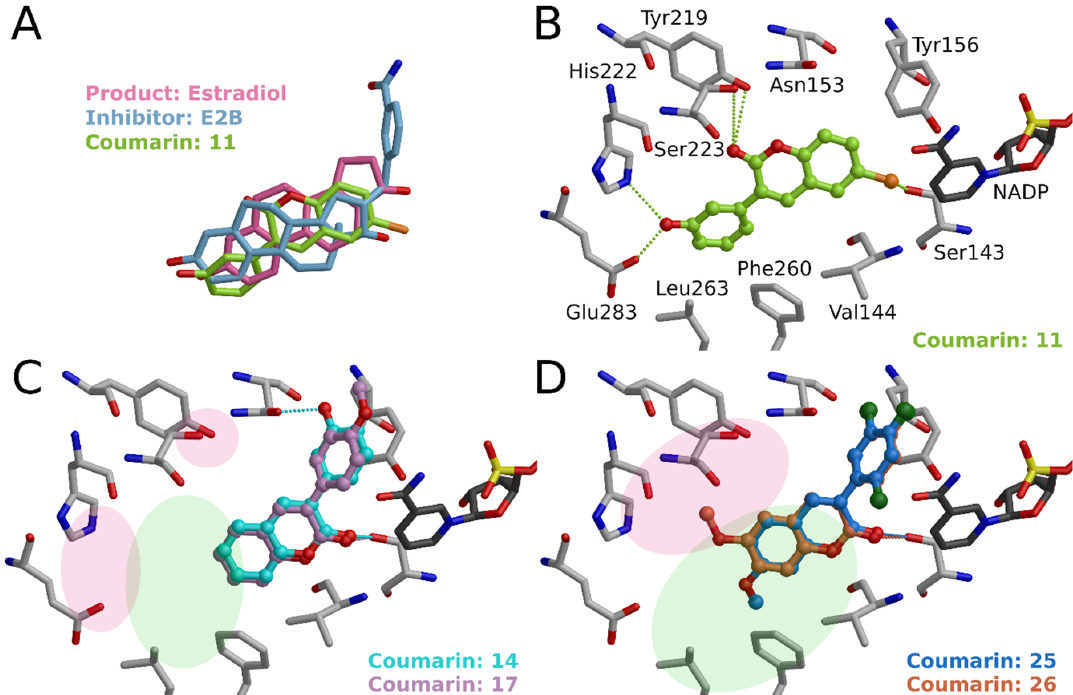
Figure 7. Binding of 3-phenylcoumarins to HSD1. ( A ) Comparison of possible binding conformations of estradiol (PDB: 1A27 [16]), E2B inhibitor (PDB: 3HB5 [17]), and 3-phenylcoumarin 11 at the binding site of HSD1. ( B ) General binding mode of 3-phenylcoumarins at the binding site of HSD1 represented by 11 . 3-phenyl ring hydroxyl substituent (R1, R2; here R1-OH) binds with His222 and Glu283. Coumarin core substituent (R5, R6; here R6-Cl) bind with catalytic Ser143 and/or Tyr156. C2-carbonyl of the coumarin core binds with Tyr219 and/or Ser233. ( C ) One of the most active compounds, 14 , has a different binding mode. R1 position hydroxyl interacts with Asn153 and C2-carbonyl with Ser143. In addition, the hydrophobic packing of this compound is excellent. 14 would offer an excellent skeleton to build a novel HSD1 inhibitor by growing a hydrophobic core (light green area) and adding potential hydrogen bond-forming groups (red area). 17 demonstrates that a similar effect is not achieved with, e.g., R2 methoxy. ( D ) Comparison of 3-phenylcoumarins that have methoxy either in R5 ( 25 ) or in R6 ( 26 ) position. Different substituent position shows that favorable R5 position methoxy can stack with, e.g., Phe260 and Leu263 (green area) whereas methoxy in R6 position ends up to unfavorably close to Tyr219, His222, and Ser223.